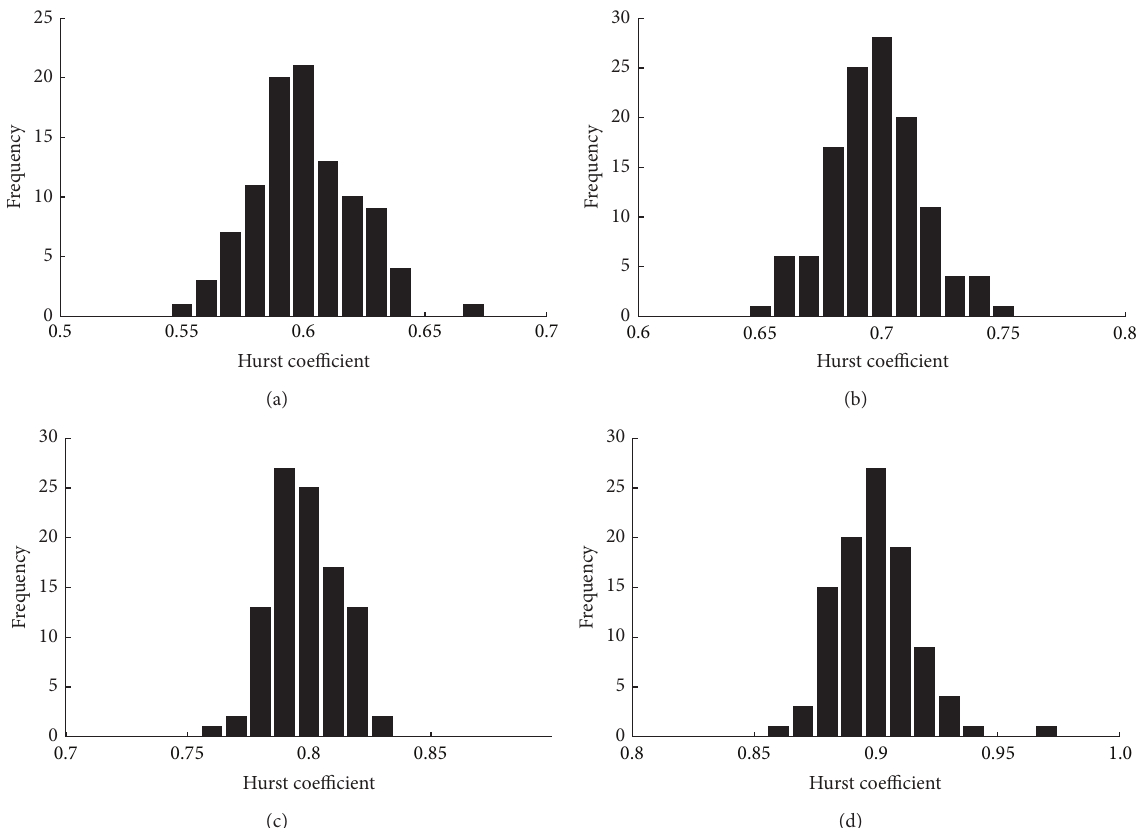
̂𝐻 for (a) 𝐻 = 0.60 , (b) 𝐻 = 0.70 , (c) 𝐻 = 0.80 , and (d) 𝐻 = 0.90